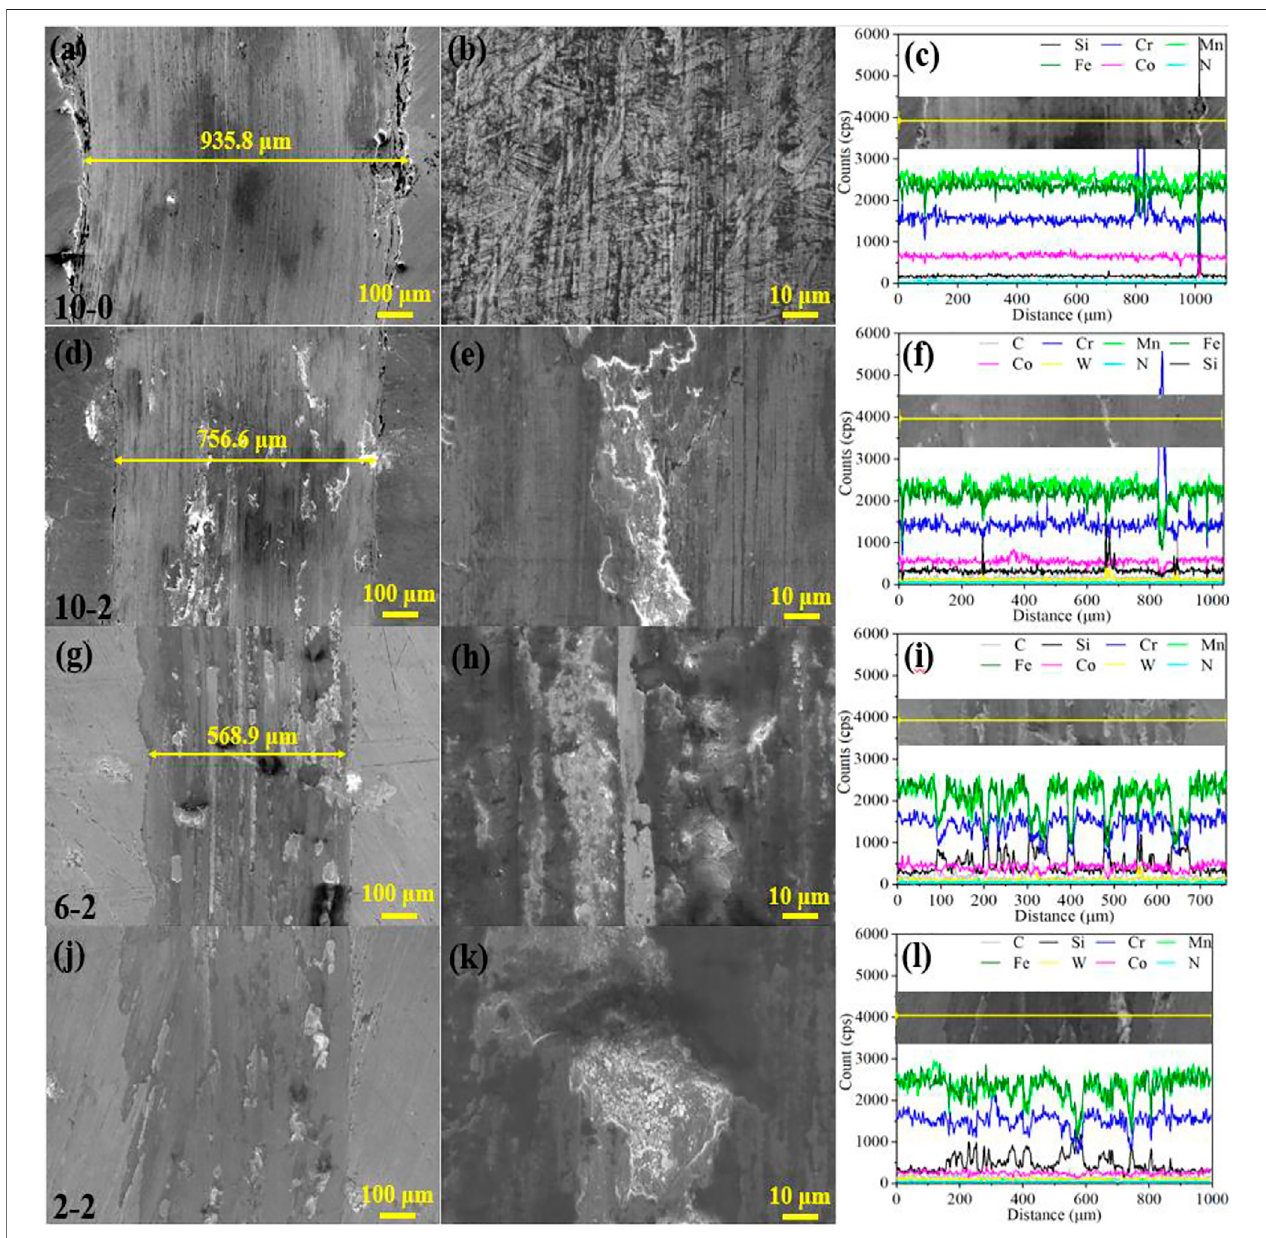
FIGURE 10 | Backscattered electron images of wear tracks in the samples and the corresponding alloying elemental distribution in line scanning. (A)(B)(C) Wear track of the 10 – 0 sample; (D)(E)(F) wear track of the 10 – 2 sample; (G)(H)(I) wear track of the 6-2 sample; and (J)(K)(L) wear track of the 2 – 2 sample.